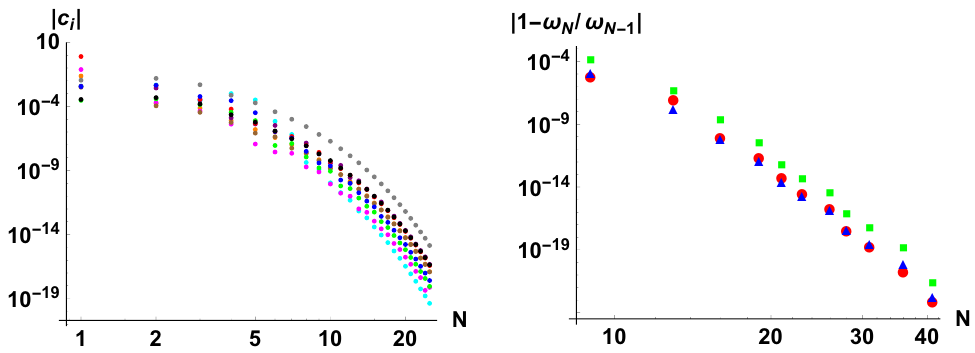
Figure 25 . The convergence of our numerics for the parameters k=T = 1 : 676 ; m=T = 4 : 189 ; B=T 2 = 105 : 276 ; (cid:22)=T = 4 : 189. The corresponding lowest three QNMs are ! 1 ;N =41 =T = (cid:6) 0 : 0804 (cid:0) 0 : 0661 i; ! 2 ;N =41 =T = (cid:0) 0 : 2045 i and ! 3 ;N =41 =T = (cid:0) 0 : 3926 i . Left: Decay of the ab- solute value of the Chebychev coe(cid:14)cients corresponding to the eigenfunctions of the lowest QNM ! 1 ( f (cid:14)(cid:30) x ; (cid:14)(cid:30) y ; (cid:14)A t ; (cid:14)A x ; (cid:14)A y ; (cid:14)h tt ; (cid:14)h tx ; (cid:14)h ty ; (cid:14)h 33 ; (cid:14)h xy g = f red, orange, magenta, brown, purple, cyan, blue, green, black, gray g ). Right: Moving of the lowest three QNMs with increasing gridsize ( f red, blue, green g = f ! 1 ; ! 2 ; ! 3 g